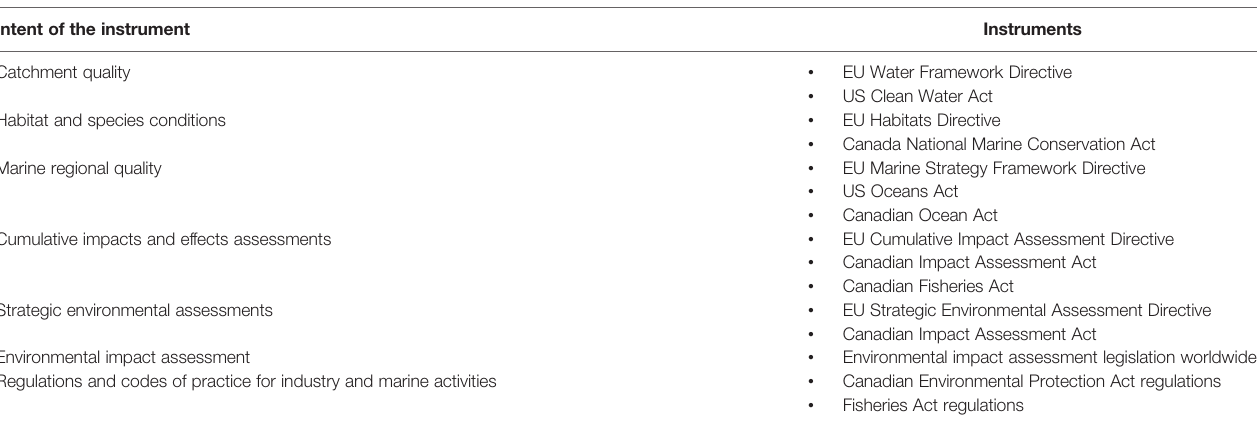
TABLE 3 | Examples of Environmental Status Assessments.